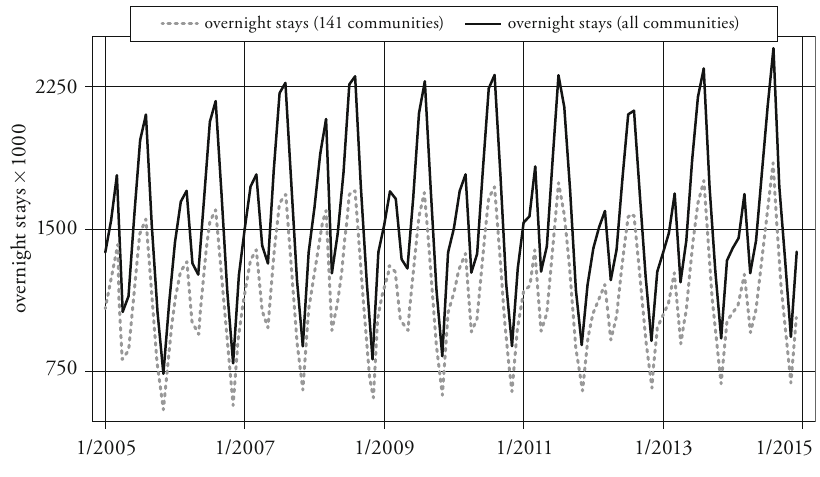
Figure : International Overnight Stays in